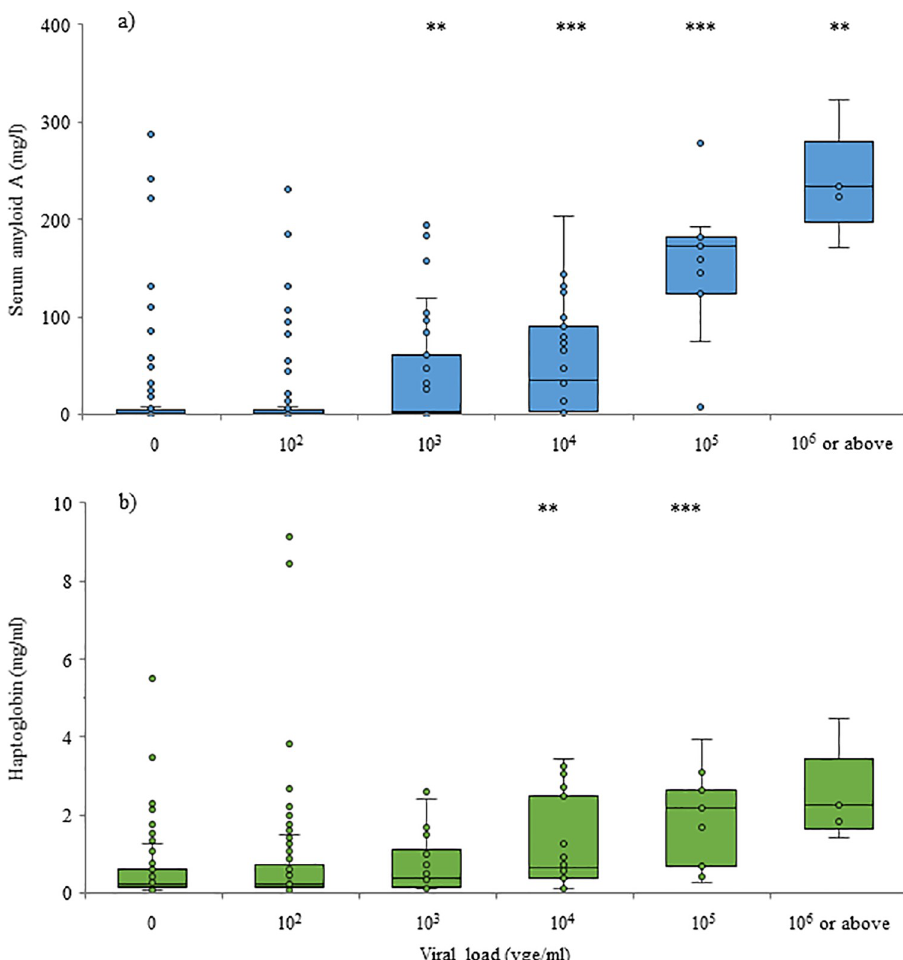
Fig 3. Acute phase protein concentrations with increasing viral load. Serum amyloid A (a) and haptoglobin (b) in elephants with differing EEHV viral loads (EEHV types combined). Box and whisker plots represent the prediction from the GLMM; asterisks denote significant differences compared to 0 vge/ml ( �� P < 0.01; ��� P < 0.001).